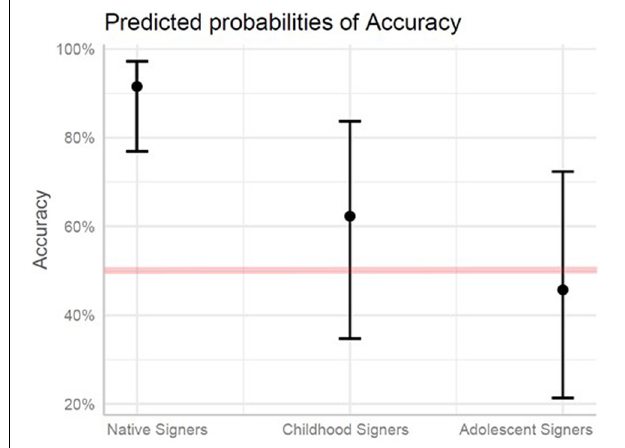
FIGURE 4 | Predicted probabilities of accuracy for native signers, childhood signers, and adolescent signers for syntax. The red line denotes chance responding